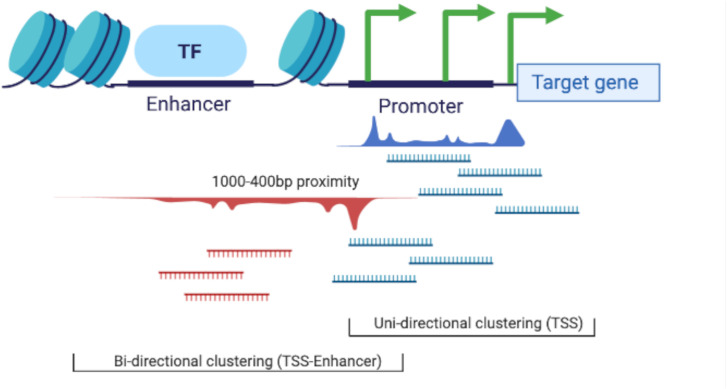
Schematic representation of the two clustering algorithms used in the CAGEfightR package for TSS (uni-directional) and TSS-Enhancer (bi-directional) clustering.